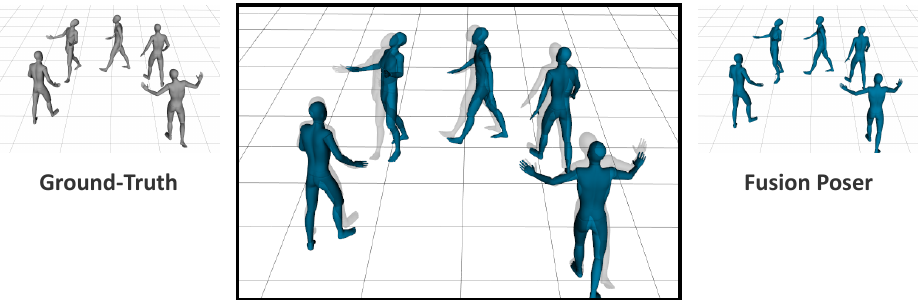
Figure 9. A comparison between the predicted and ground-truth poses using TotalCapture data (S4). By overlaying the predicted and ground-truth results, we could visualize the